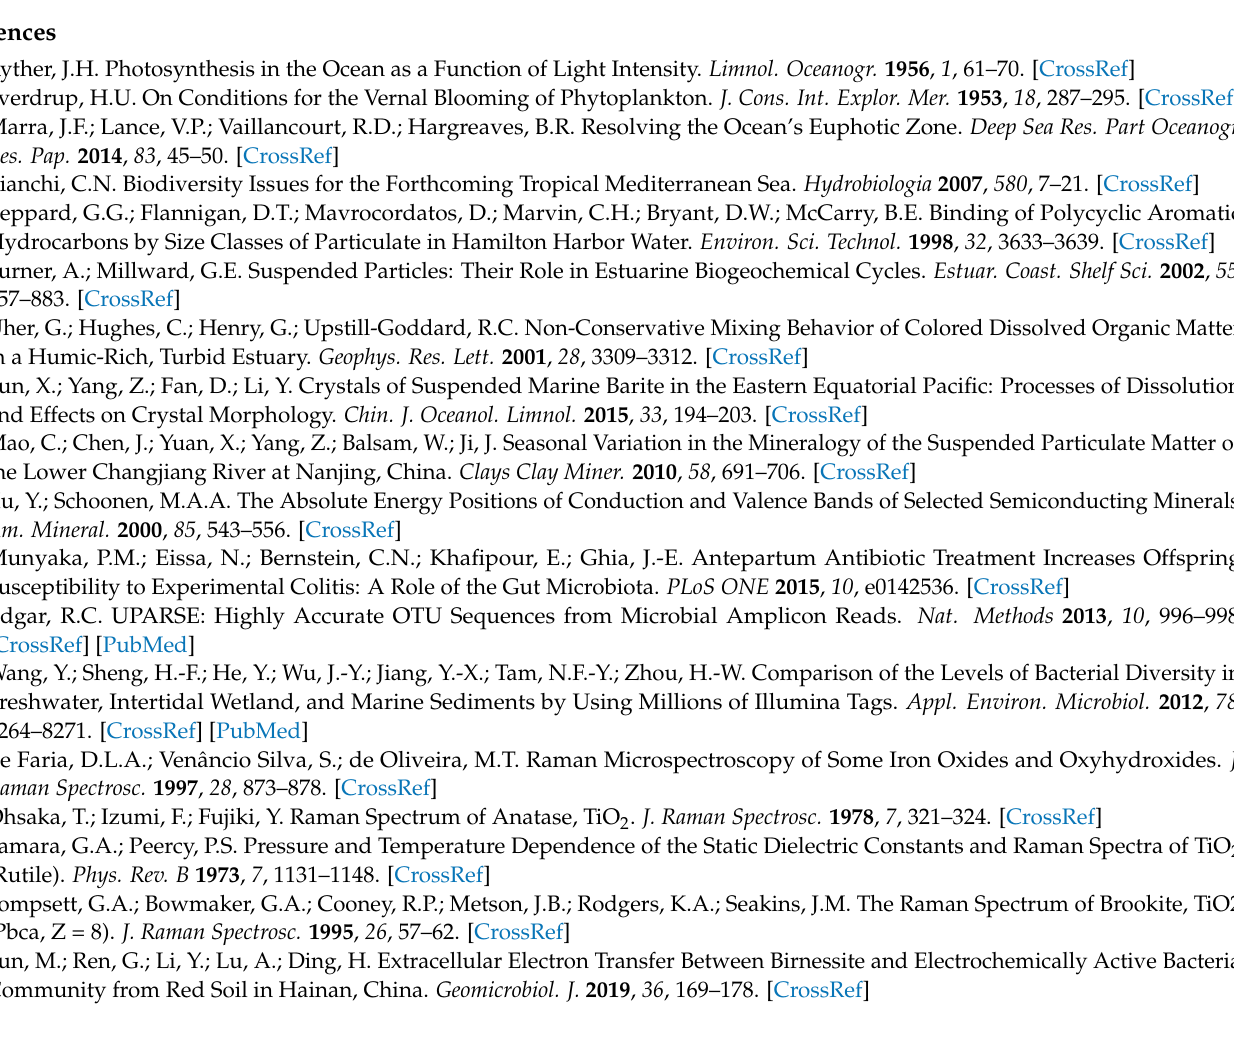
Table S1: The range and average value of element abundance of suspended particulate matters in different